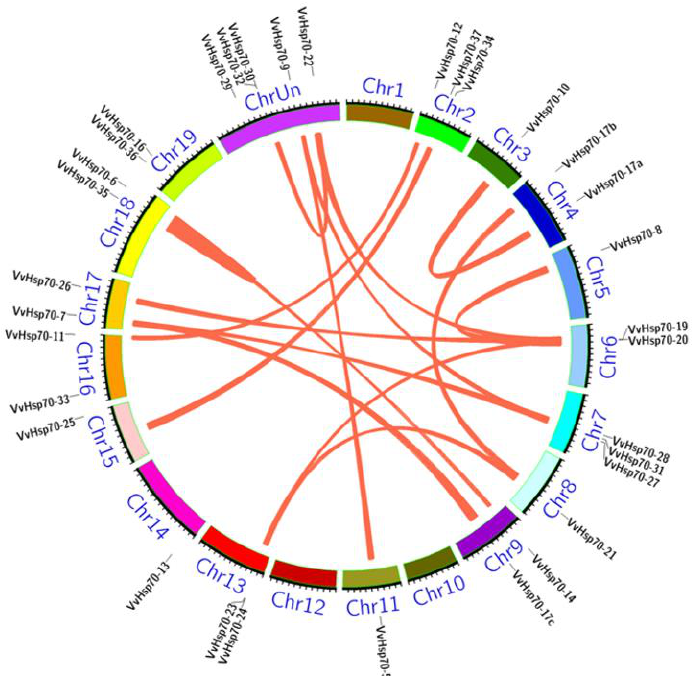
Figure 4. Chromosome distribution and duplication analysis of VvHsp70 genes. Different chromo- somes are drawn in different colors. The approximate positions of VvHsp70 genes are indicated by short black lines on the circle. Red curves represent the duplication events between VvHsp70 genes. Chrs 1-Un: Chromosome 1-Un.